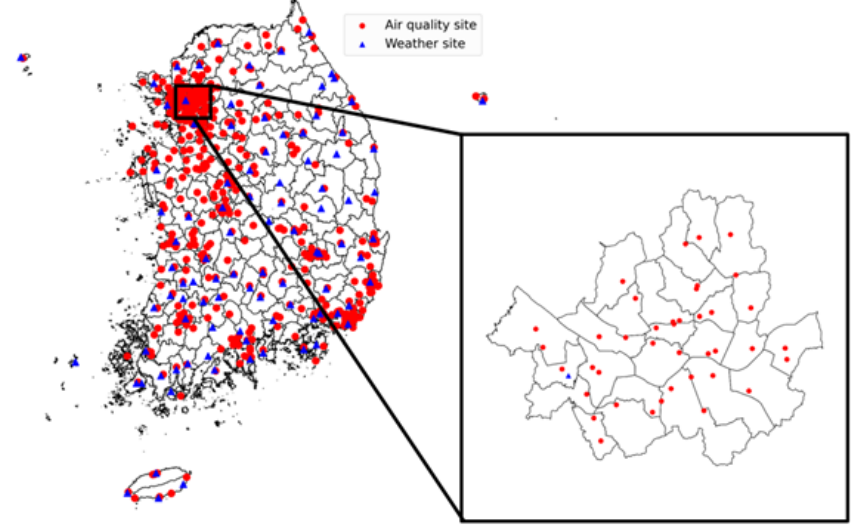
Figure 2. Spatial distributions of weather ( (cid:78) ) and air quality ( • ) measurement sites in Seoul.